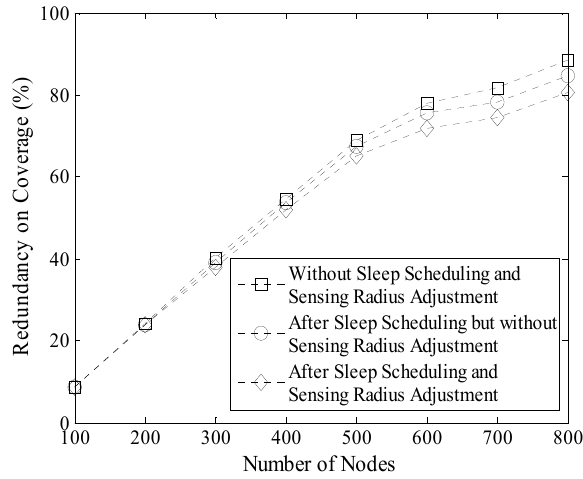
Figure 17. Number of active nodes in LDGM (200 m × 200 m).